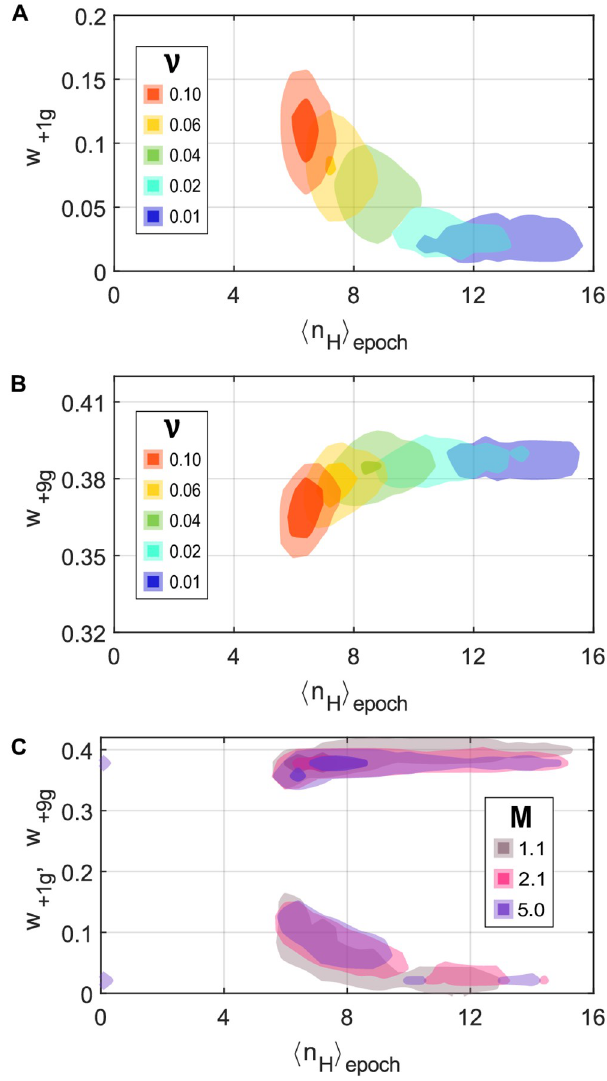
Fig 5. Trade-off between minimizing adaptation time and maximizing phenotypic robustness correlates with nonlinearity. Contour plot of the bi-variate histogram of the average Hill coefficient per epoch h n H i epoch and the population fitness at the (A) first generation w +1 and (B) ninth generation w +9 after an environmental transition are g g shown grouped by the environmental fluctuation frequency ( ν ). (C) An analogous plot but grouped by the mutation step-size value ( M ; three example values) shows that the observed trend is related to the ν value. In all cases, the last 100 epochs of ten independent replicas were considered, each simulation running for 10,000 generations with evolutionary parameters N = 10000, s = 40, u = 0.03 and k = 80, n = 6 and K = 45 as the initial genotype ( θ 1 ; this initial genotype t H D sped up evolutionary simulations by being closer to final selected genotypes in all simulations). In each group, the shade area shows the bins with at least 1% of cases, and at least 5% of cases in the darker